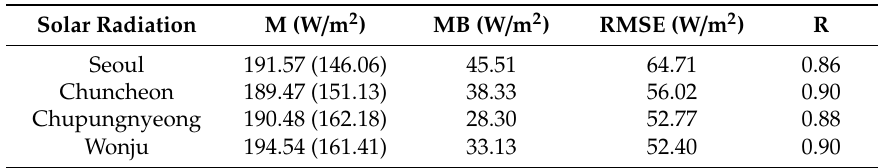
Table 8. Solar Radiation mean (M), mean bias (MB), root-mean-square error (RMSE) and Correlation Coefficient (R) between Weather Research and Forecasting (WRF) model and weather station measurements.